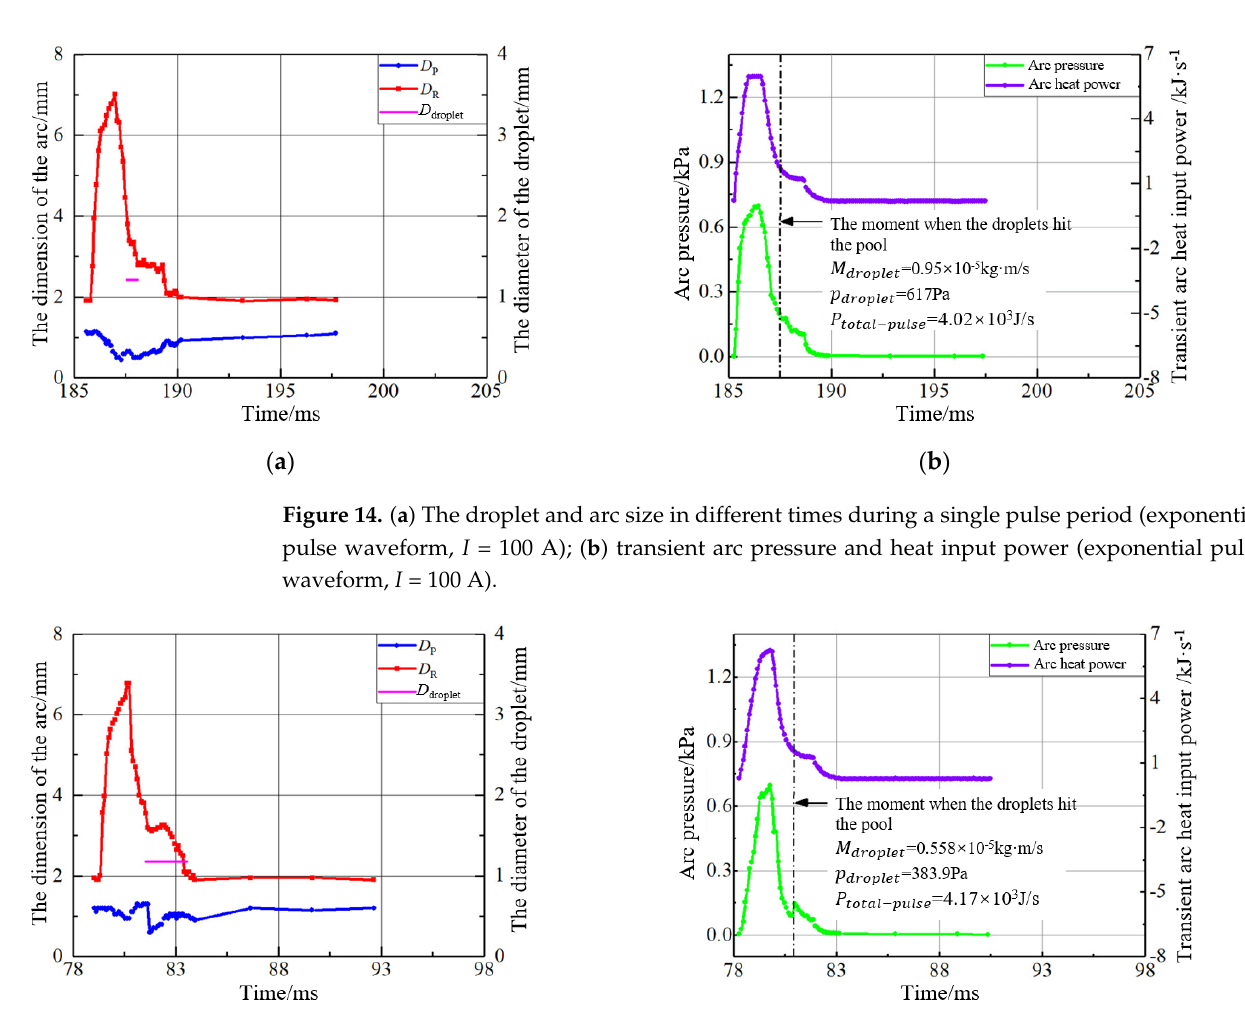
13 of 22 Figure 13. P-GMAW current and voltage signal and arc and droplet transition behavior photo- graphs (exponential pulse waveform, I = 100 A): ( a ) current and voltage signal; ( b ) synchronous photographs. The droplet projection size of the trapezoidal pulse waveform was 1.156 mm 2 , and the velocity was 1.28 m/s. The droplet projection size of the exponential pulse waveform was 1.09 mm 2 , and the velocity was 0.82 m/s. Previous studies have proven that the in- crease of I p could lead to the simultaneous increase of electromagnetic force and high- speed convection intensity in the droplet and then increase the initial velocity of the drop- let [20]. Under the same I p condition, the trapezoid pulse takes less time for the droplet to detach from the wire. The current is 300 A when the droplet detangles from the wire of the trapezoid pulse, which is significantly higher than that of the exponential pulse (the current is around 200 A when the droplet detaches from the wire), which results in a stronger driving effect on the arc of the trapezoid pulse after the droplet detangles from the wire (as shown in Equation (14)). As a result, the droplet has a large acceleration and initial velocity [21 – 24]. The droplet and arc sizes of the two waveforms in a single pulse cycle are shown in Figures 14a and 15a. Combined with Equations (6) – (11), the heat and force acting on the weld pool in a single pulse cycle can be calculated, as shown in Figures 14b and 15b. It can be found that the welding heat input power of the trapezoidal pulse and exponential pulse are similar, and the maximum value of arc size is close. However, the increase rate of arc size of the trapezoidal wave is significantly faster than that of the exponential wave, and the change of arc pressure shows a similar trend with the arc size. Although the peak arc pressure of the two waveforms is similar, the increased rate of arc size of the trapezoi-